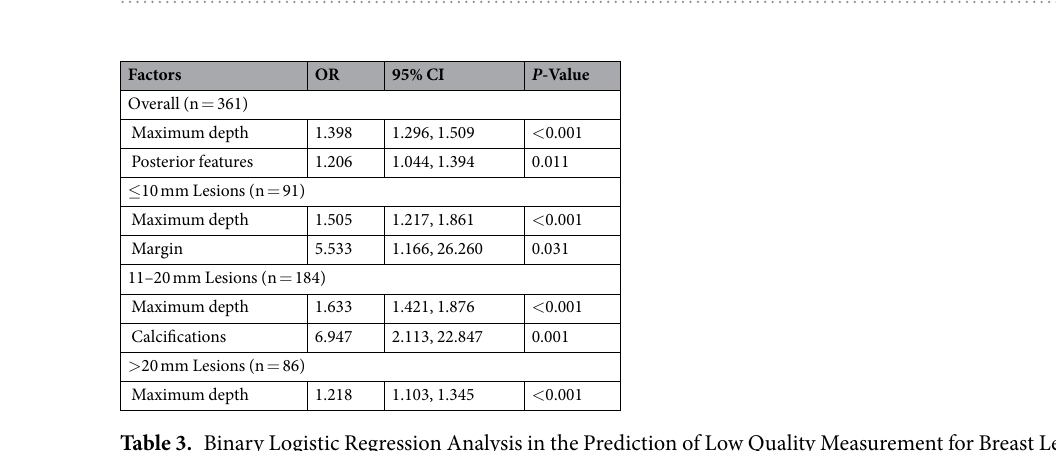
Table 2. The characteristics of patients and the US features of breast lesions in subgroups. * Indicates a significant difference. US = ultrasound SWV = shear wave velocity Changed posterior features included enhancement, shadowing and combined pattern.